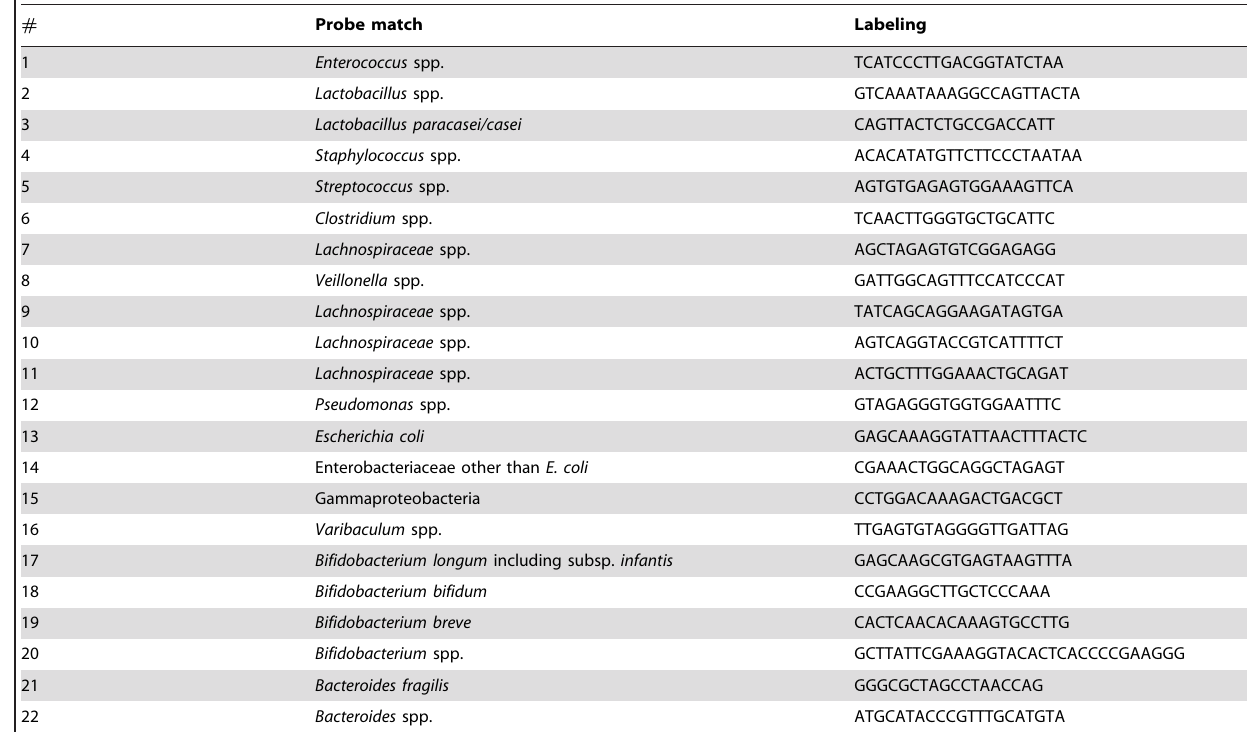
Table 2. Probes and their